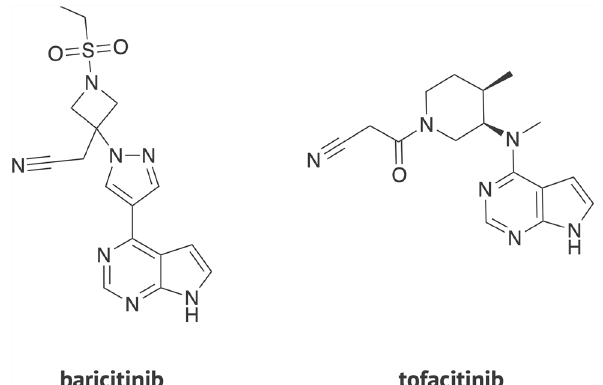
Figure 1. Chemical structure of baricitinib and tofacitinib. The two drugs were the first JAK inhibitors to receive approval in the USA and Europe to treat rheumatoid